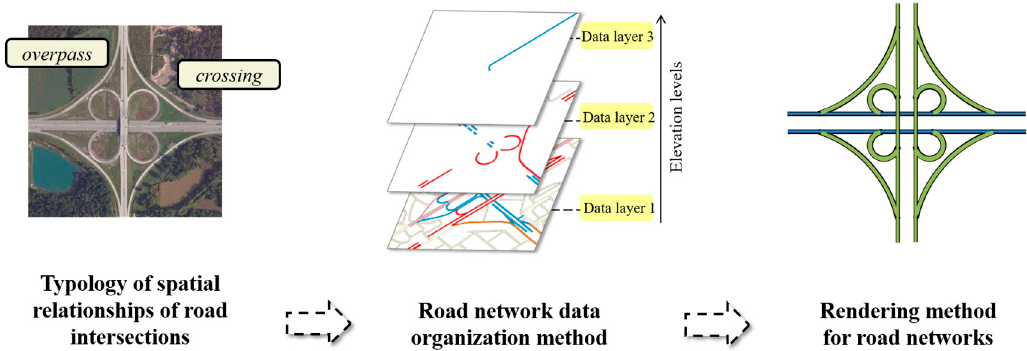
Figure 6. Research pipeline of the proposed method